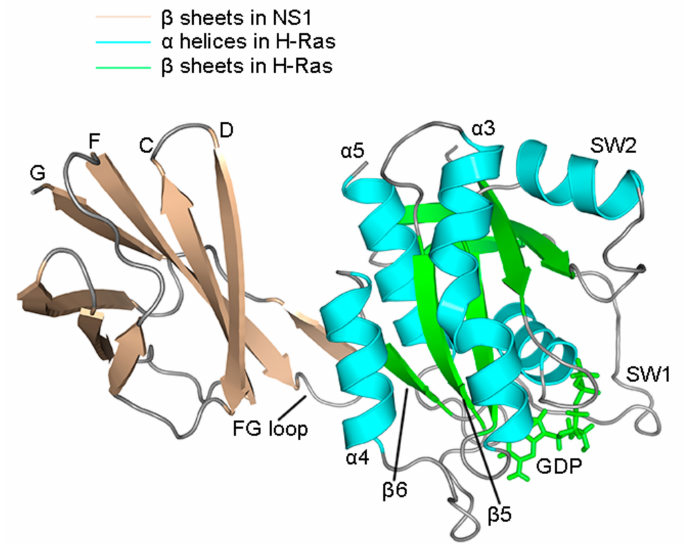
Figure 3. Cartoon structure of H-Ras–NS1 complex, with the major secondary structures specified. SW1 and SW2 represent the Switch 1 and 2 regions, respectively. β sheets in NS1 and H-Ras are colored in wheat and green, respectively. α helices in H-Ras are colored in cyan and loops are in